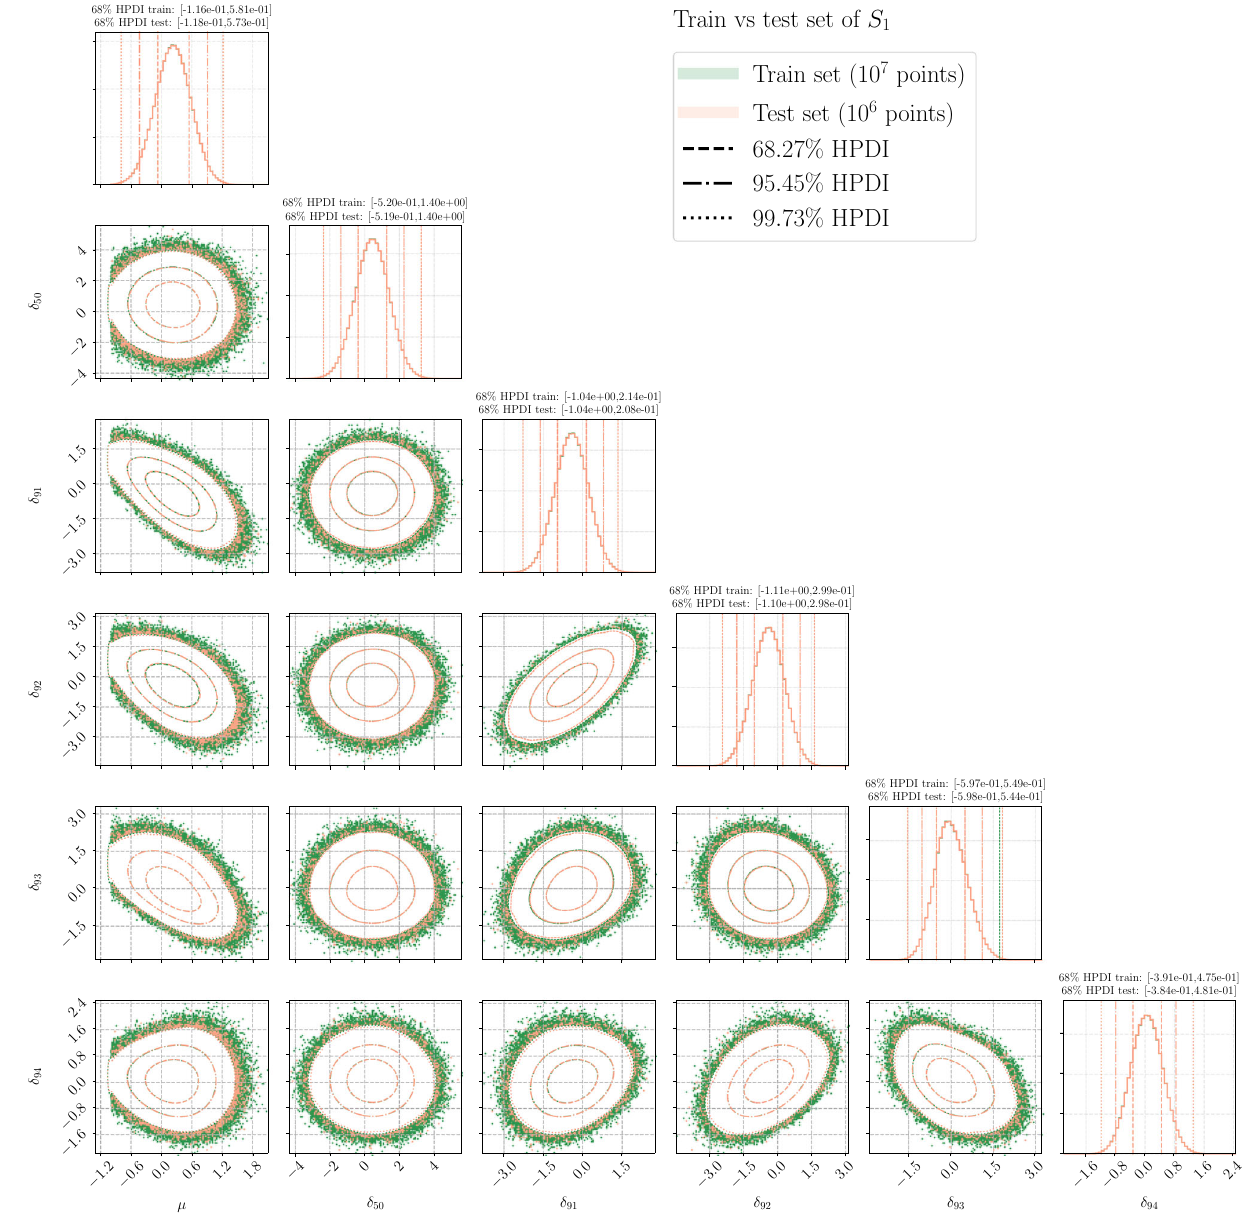
Fig. 6 1D and 2D posterior marginal probability distributions for a subset of parameters from the unbiased S 1 . This gives a graphical repre- sentation of the sampling obtained through MCMC. The green (darker) and red (lighter) points and curves correspond to the training set (10 7 points)andtestset(10 6 points)of S 1 ,respectively.Histogramsaremade with 50 bins and normalised to unit integral. The dotted, dot-dashed,